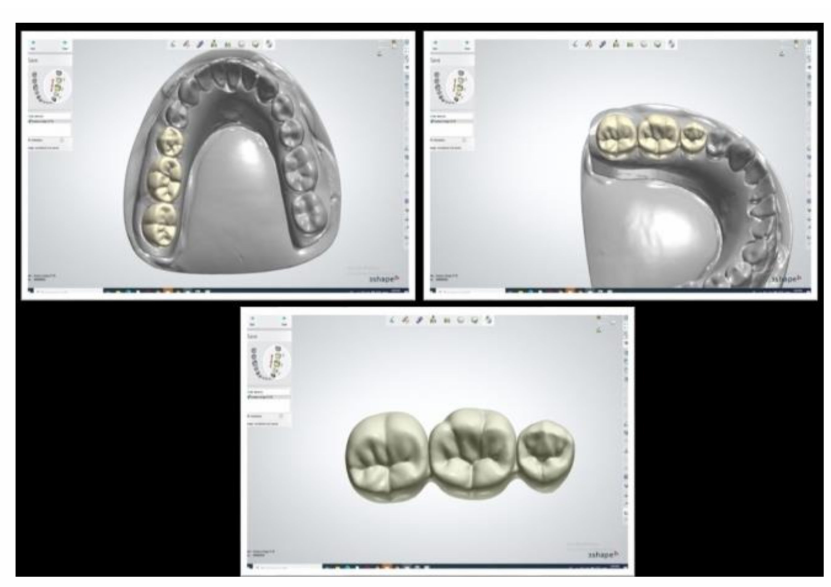
Figure 4. Selection of design.